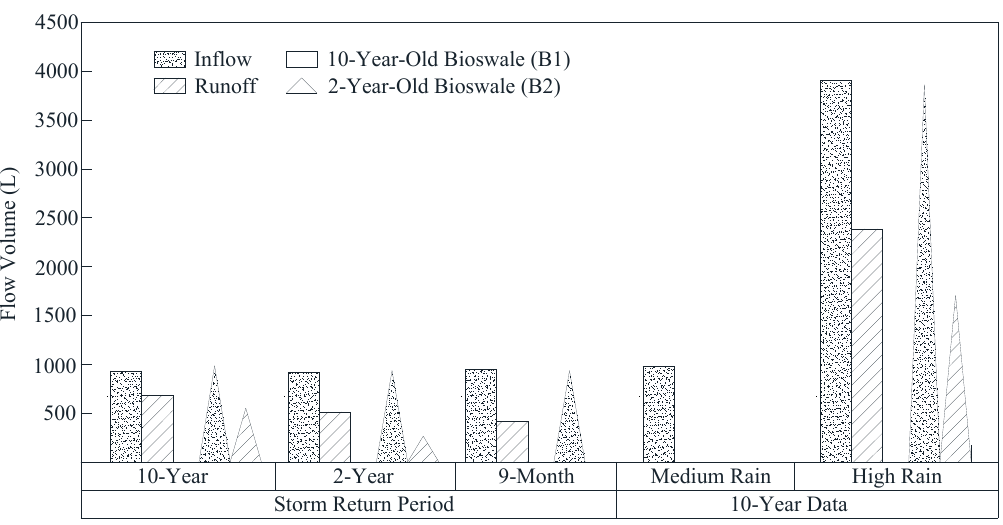
Figure 6. Field-test results for the 10-year-old bioswale and 2-year-old bioswale under various rainfall scenarios.